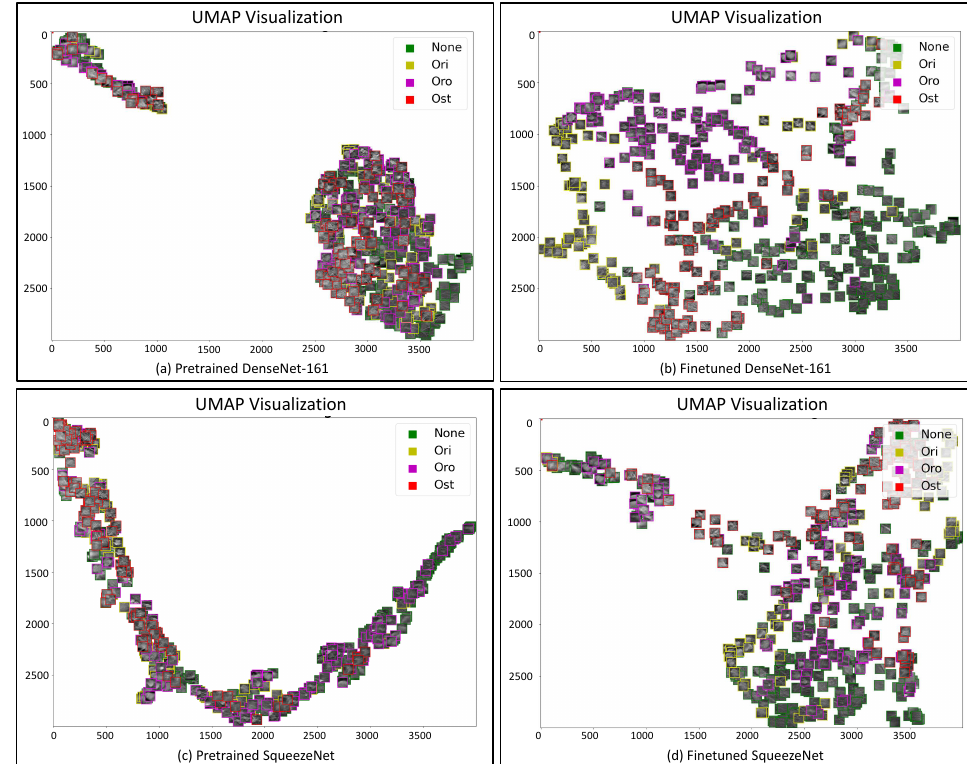
Figure 10. The UMAP embedding plots of the features extracted from the pretrained ( a , c ) and fine-tuned ( b , d ) DenseNet-161 and SqueezeNet, respectively, on the validation set of 1st fold. It is distinctly visible that the fully TL paradigm does not allow a clear clustering of the features in low-dimensionality space, whereas the finetuned model is able to discover more discriminative features with respect to its pretrained-only